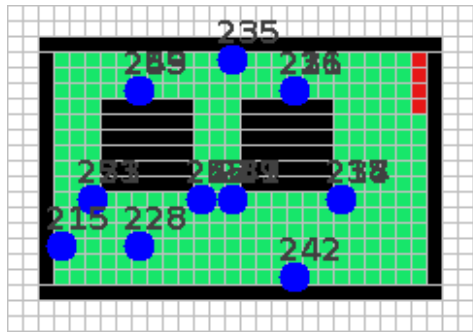
Figure 4. WSN deployment in a data centre room at the Informatics Institute at Federal Fluminense University